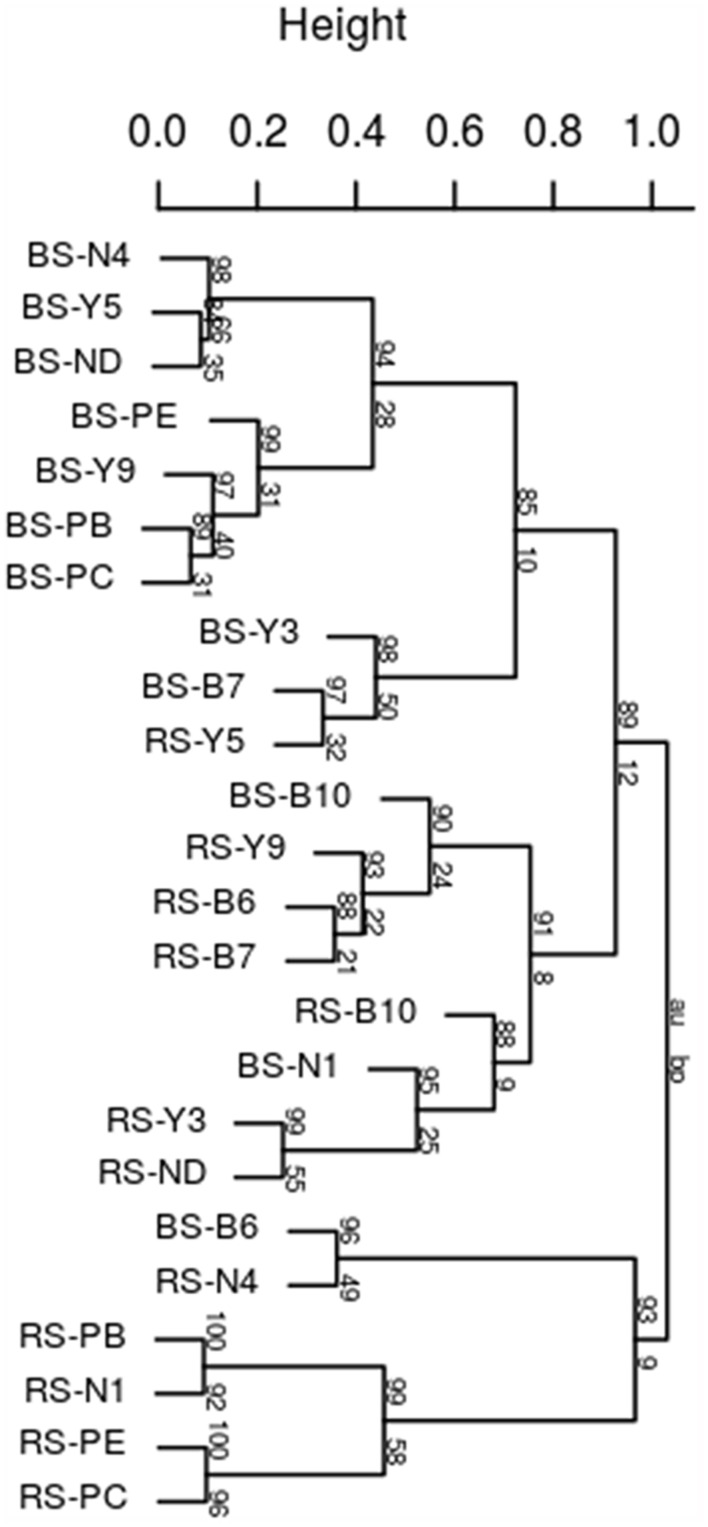
Dendrogram of bacterial community fingerprints. UPGMA cluster analysis based on Pearson correlation distance obtained by DGGE samples taken from bulk soils (b) and the corresponding Rhododendron arboreum rhizosphere. Approximately unbiased (au) p-values at the edges of the cluster were obtained by multiple bootstrap resampling (n = 1000).